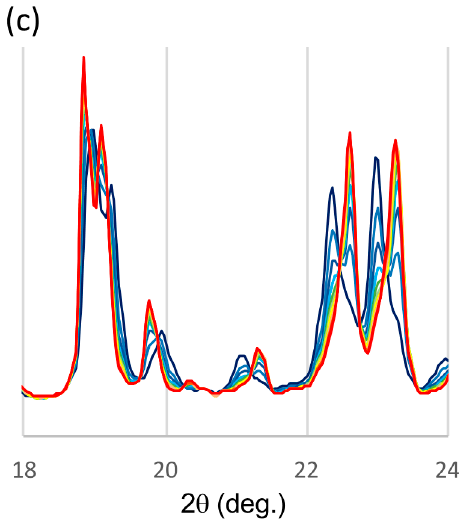
Figure 5. SR-XRD patterns from LLL crystals in β ’ route. ( a ) Time evolution on small- and wide-angles X-ray scattering (SAXS and WAXS). The temperature change during the measurement is on the right. Di ff raction intensity is shown in rainbow colors from violet to red. ( b ) SAXS and WAXS profile changes from di ff erent polymorphs. The triangles in ( a ) indicate the time of each profile. ( c ) WAXS pattern development during isothermal heat treatment at 35 ◦ C for 1 h (*). The XRD profile was extracted every 5 min from violet to